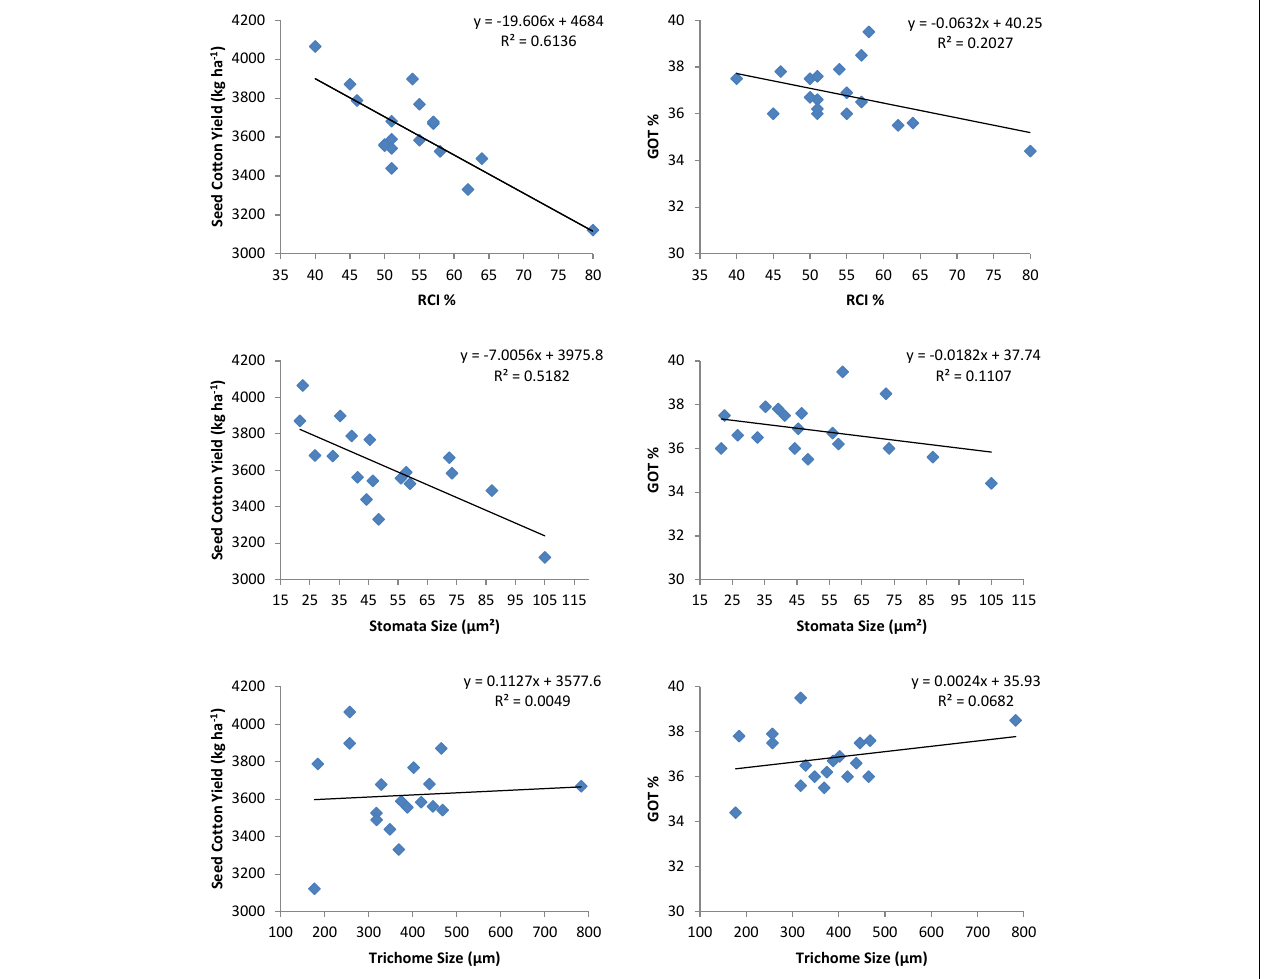
FIGURE 3 | Relationship of physiological traits with seed cotton yield (kg ha - 1 ) and ginning out turn percentage (GOT%) of selected heat-tolerant cotton